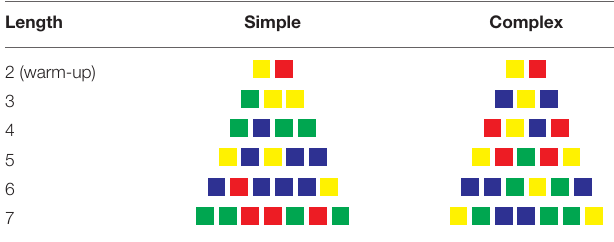
TABLE 1 | Sample of sequences in the Simple and Complex conditions, up to seven items. Length Simple